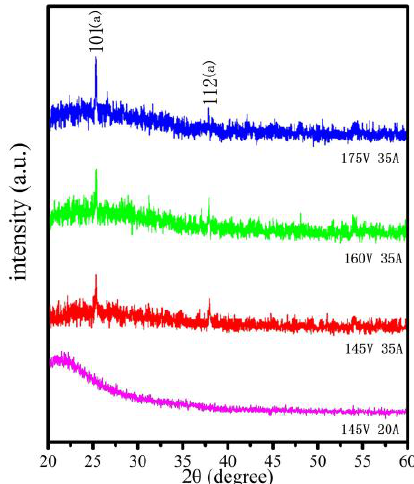
Figure 5. XRD results for a range of AV/AC settings, for current settings below 35 A it was found that amorphous TiO 2 phases are observed in the XRD pattern. Peaks for anatase phases (101) and (112) were observed when AC was set to 35 A.